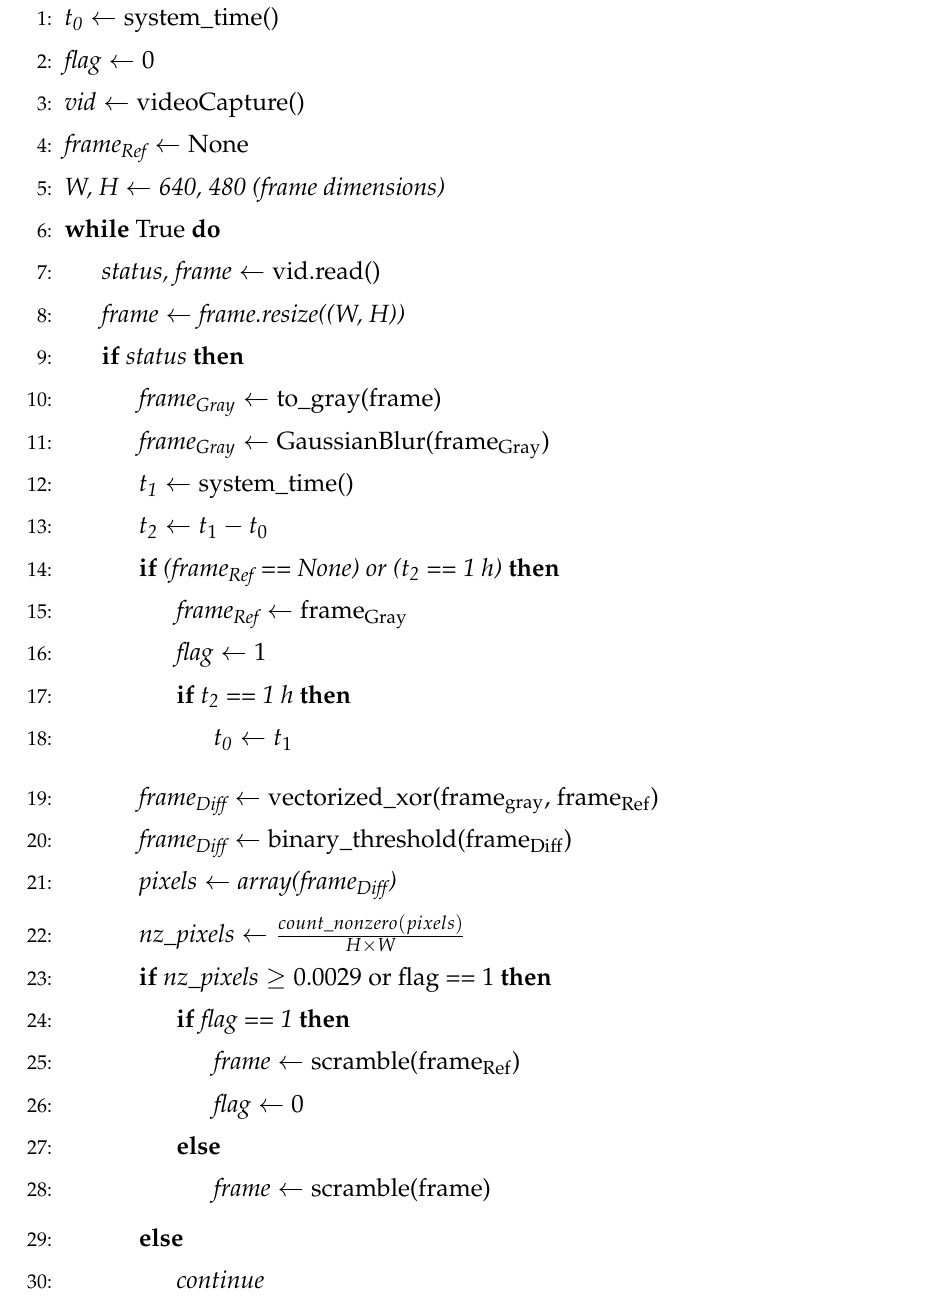
Algorithm 1 @ Edge Camera Foreground